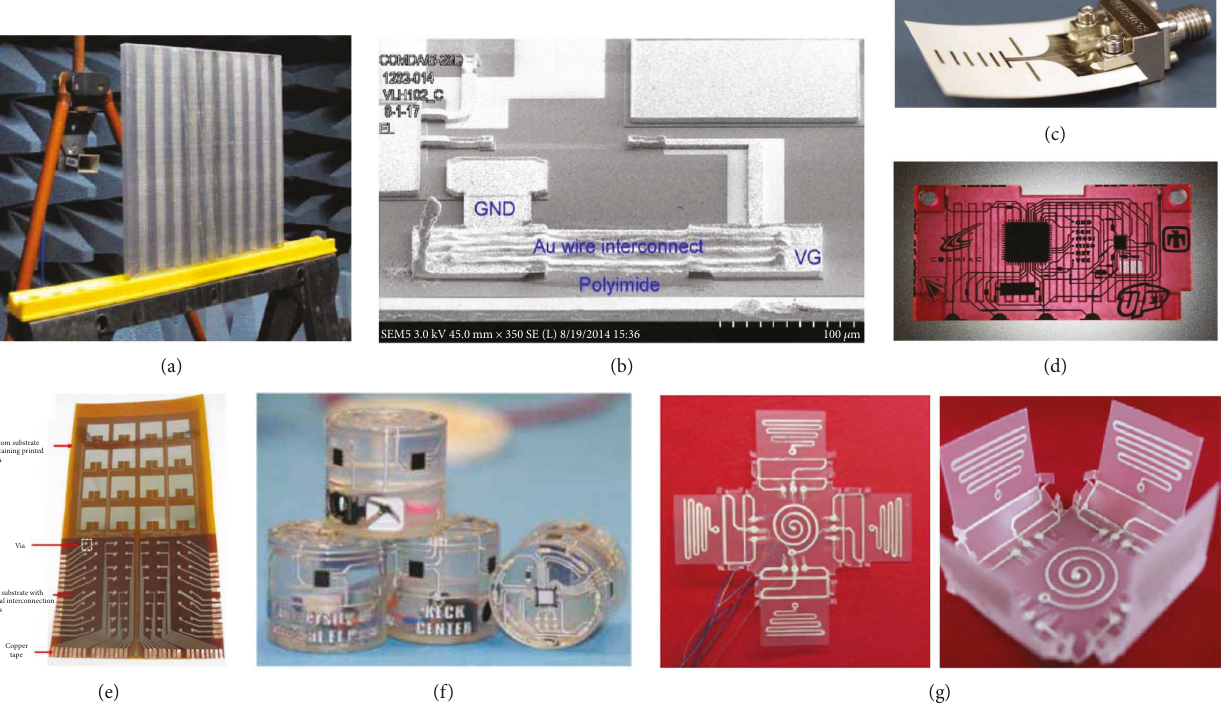
Figure 7: Demonstrations of 3D printed RF components. (a) All-dielectric frequency selective surface under C-band testing. Reproduced with permission from [91]. (b) SEM image of postreliability tested printed gold wire interconnect. Reproduced with permission from [13]. (c) IJP-printed mm-wave Yagi-Uda antenna on fl exible substrate. Reproduced with permission from [92]. (d) Multifunctional